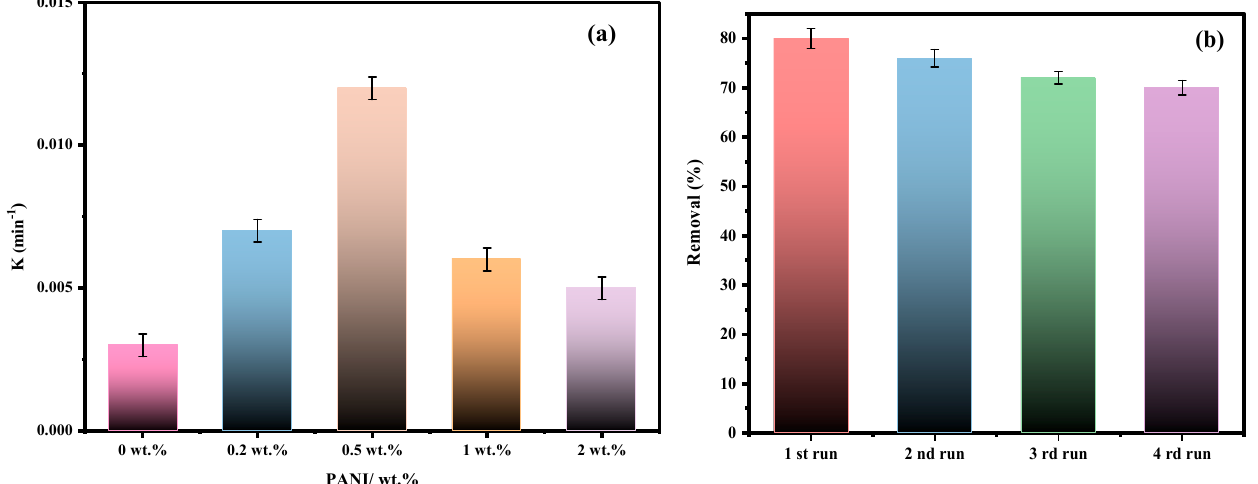
Figure 9. ( a ) Rate constant of Bi 2 O 3 -BiOCl and PBB composites. ( b ) Reuse of 0.5PBB for the photocatalytic degradation of MB under solar light illumination.